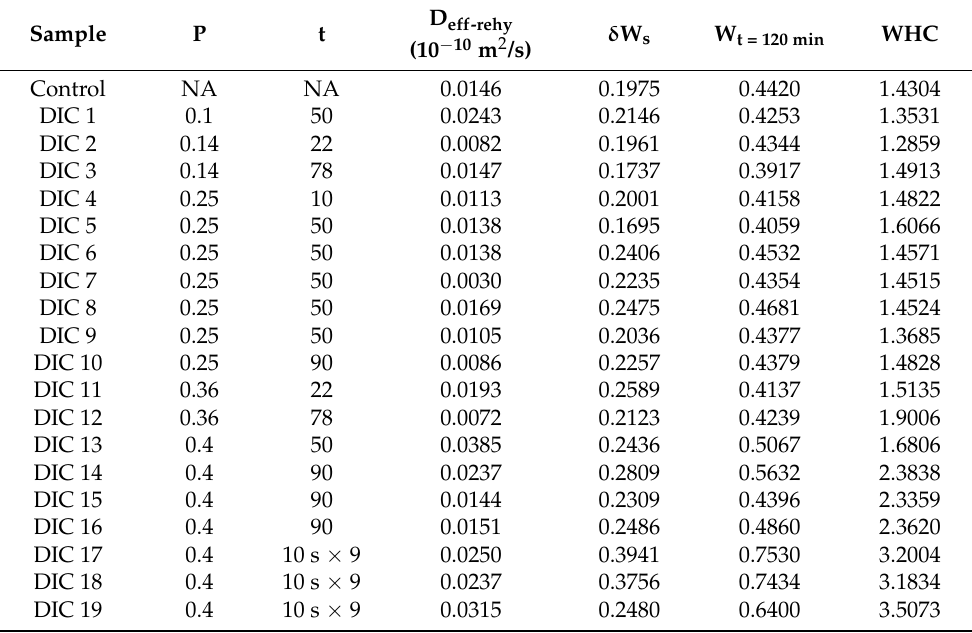
Table 5. Effect of DIC treatment on the rehydration kinetic parameters of maize